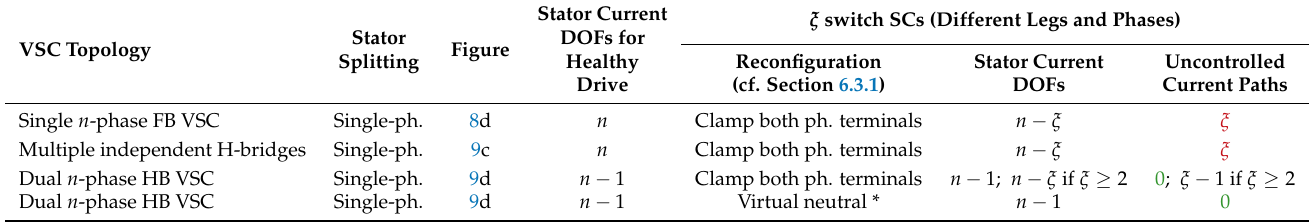
Table 30. Number of stator current DOFs and uncontrolled current paths of different VSC topologies and reconfigurations for an n -phase machine under non-isolated switch SCs (in different legs and phases).